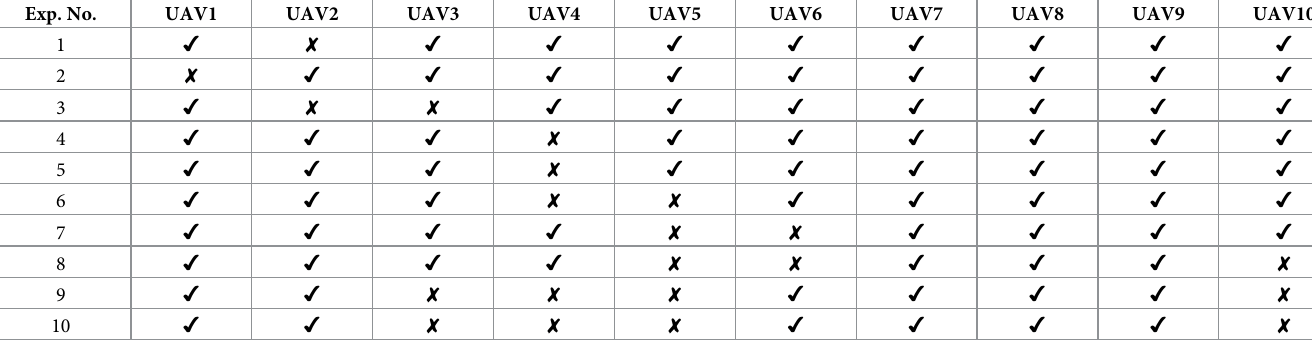
Table 1. UAV Selection obtained from 10 deterministic exhaustive search experiments of Fig 6(a). Exp. No.